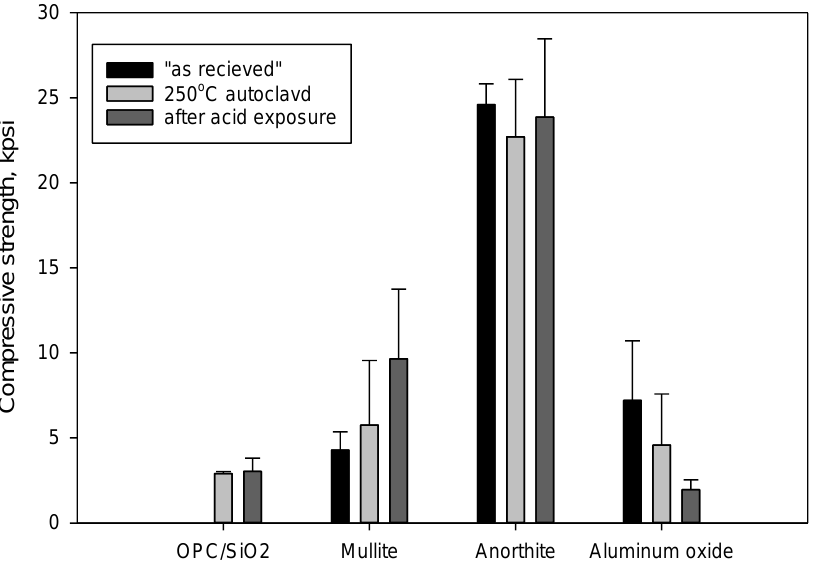
Figure 10. Compressive strength of “as received”, 250 °C autoclaved and acid exposed samples.